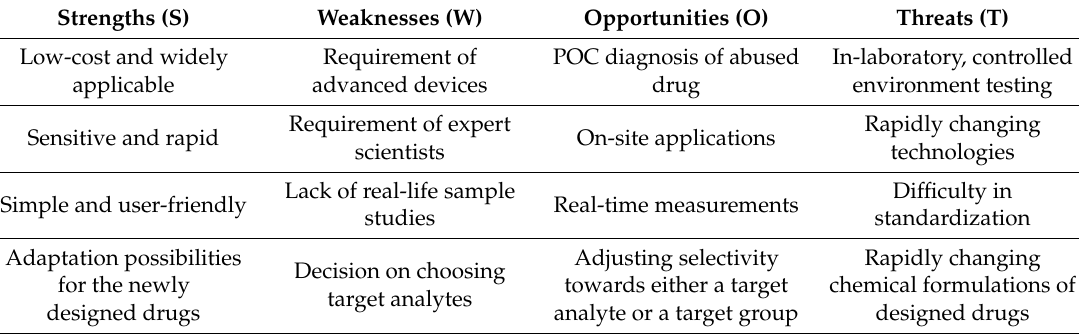
Table 1. SWOT analysis on aptasensors for abused drug detection.